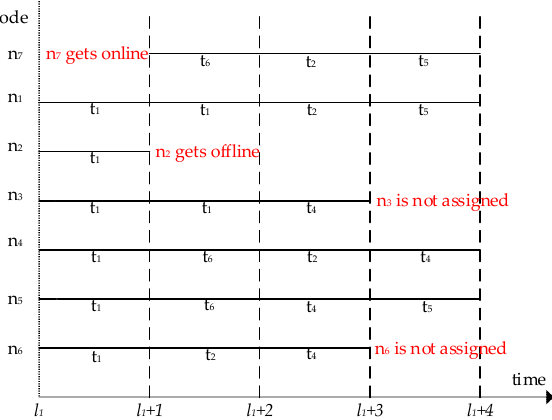
Figure 7. The execution processes of the improved dispatch constraint scheduling (IDCS) algorithm.